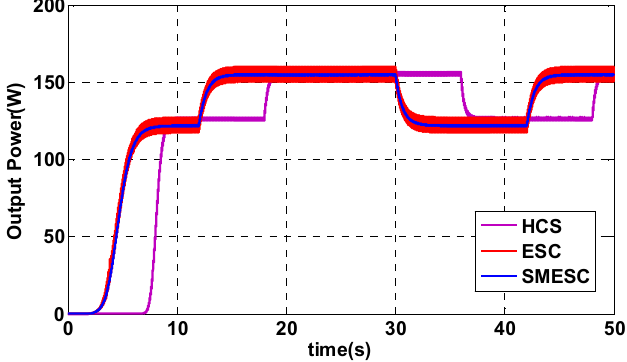
Figure 12. Three algorithm system dynamic responses: Low wind speed raised and lowered